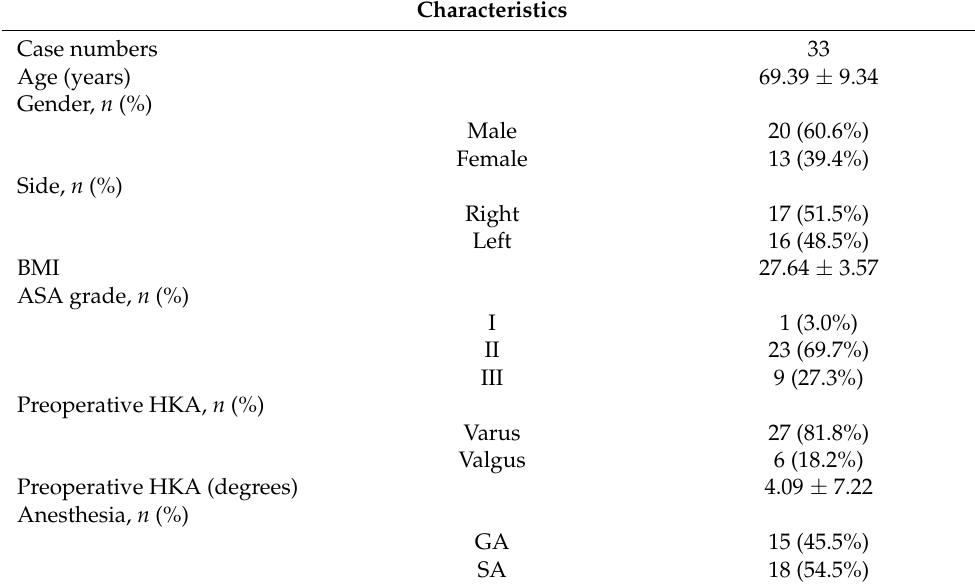
Table 1. Demographics and characteristics of enrolled